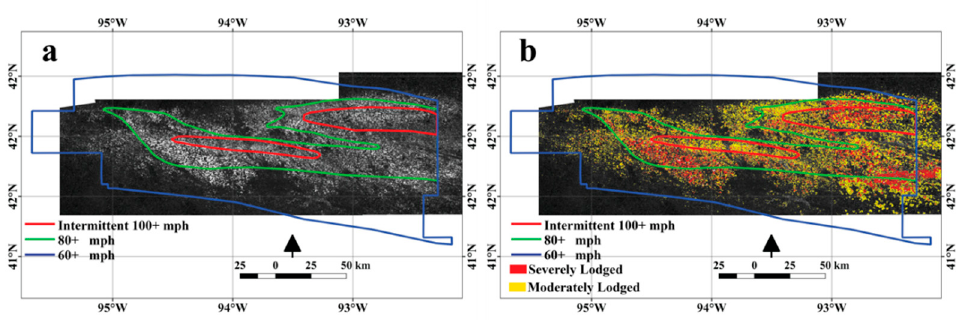
Figure 9. Example of ( a ) ratio map (Figure 5b) and ( b ) severity map (Figure 7b) overlaid with wind speed map in Figure 2.